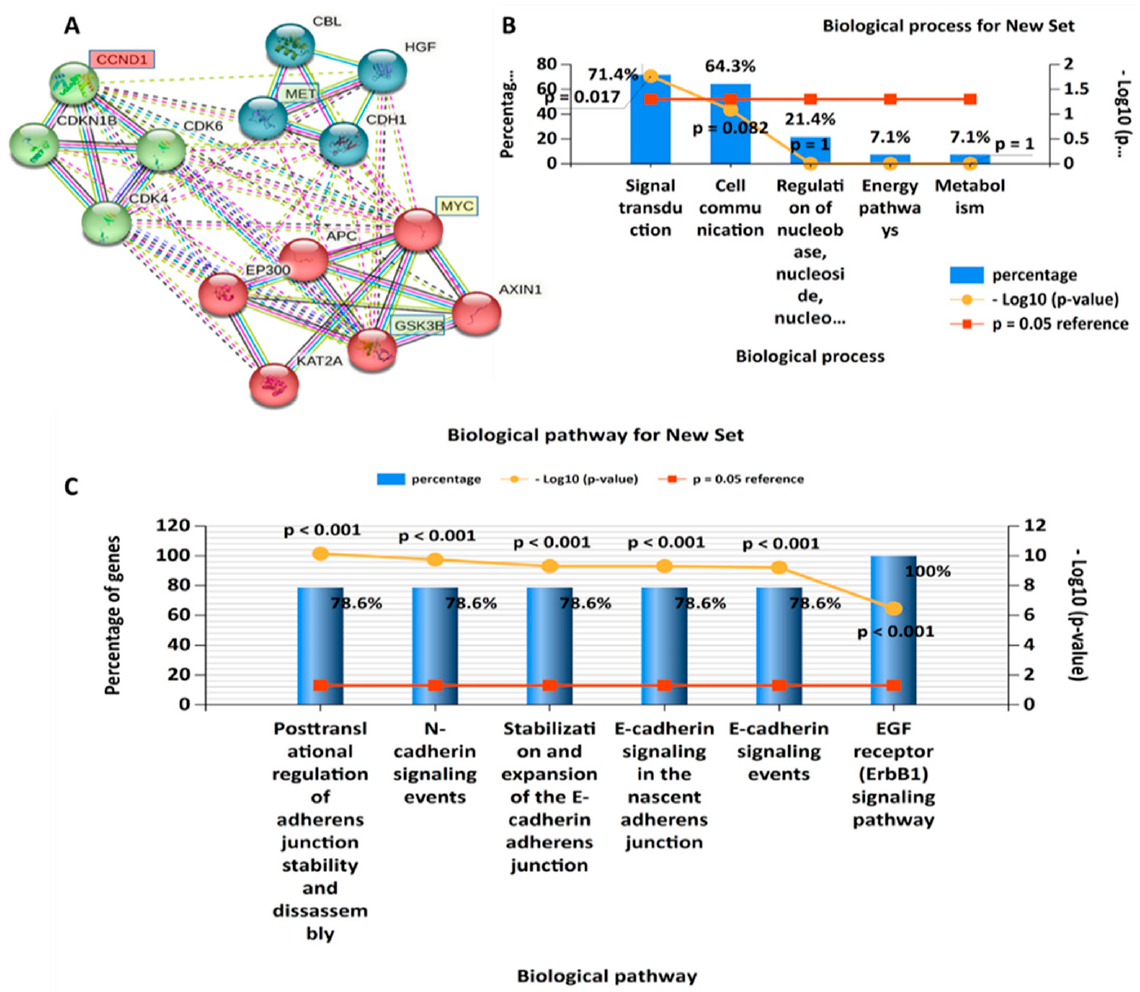
Figure 3. Protein–protein interaction (PPI) network revealed interactions among the c -Met/GSK3 β /MYC/CCND1 oncogenes in colorectal cancer (CRC). ( A ) The average local clustering coefficient was 0.920 with interaction enrichment of p = 0.0135. Interactions were based on coexpressions, gene fusion, and co-occurrences. ( B ) The top 10 biological processes (BPs), ( C ) KEGG pathways, with p < 0.05 were considered significant.